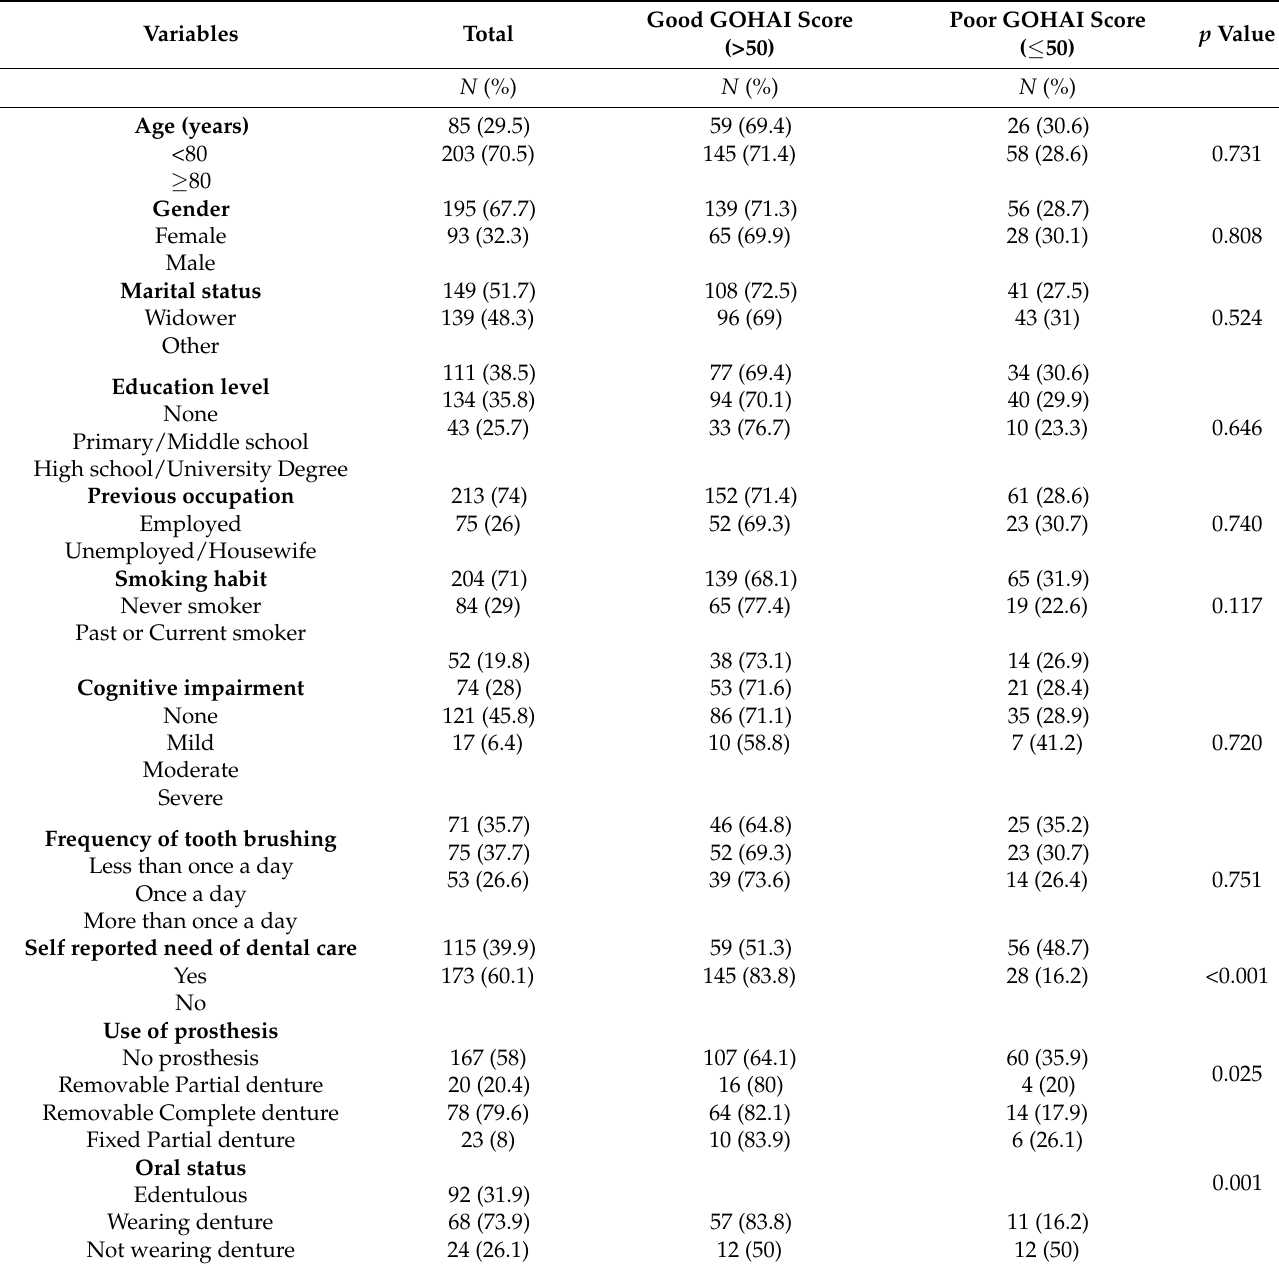
Table 1. Frequency distribution of sociodemographic and clinical variables according to the Geriatric Oral Health Assessment Index (GOHAI)